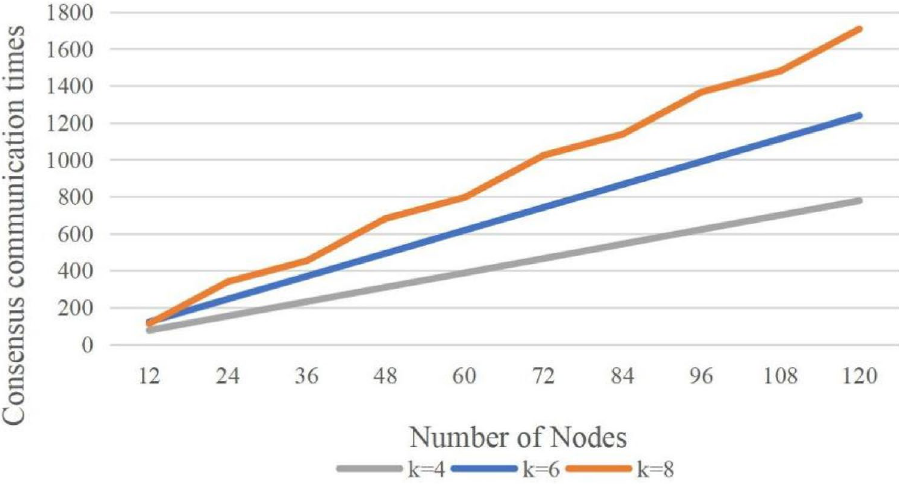
Figure 5. GPBFT communication overhead for different number of nodes in a